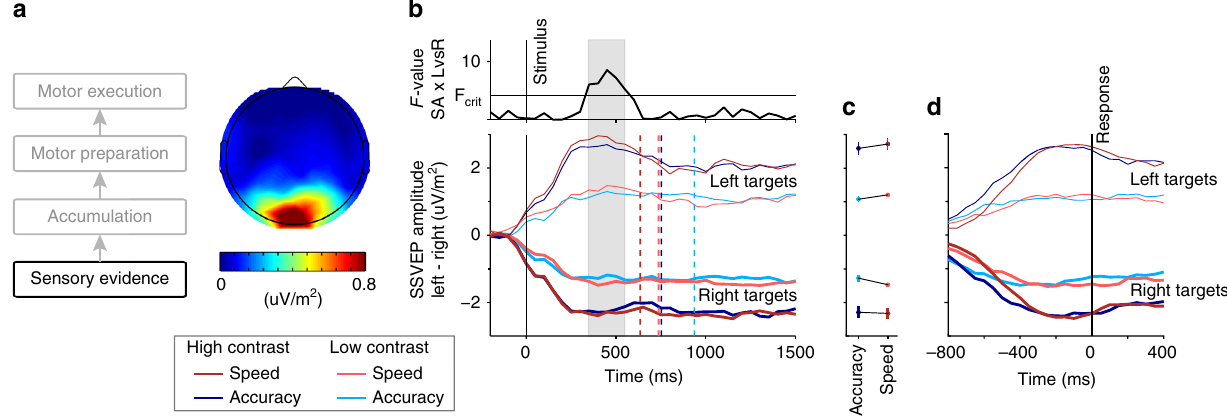
Fig. 2 Sensory evidence modulations due to speed pressure. a Average steady-state visual evoked potential (SSVEP) measured in the 800 ms before stimulus onset was maximal at occipital electrodes around standard site Oz. b The difference in amplitude between the steady-state visual response to the left- and right-tilted gratings underwent clear changes in the direction of the Target Type (increased-contrast in the left/right-tilted grating, thin/thick lines), and this directional effect varied in strength as a function of high/low Contrast difference (dark/light shades), and Speed/Accuracy Regime (red/ blue). Speci fi cally, there was an increased separation between the stronger sensory representation of the increased-contrast and the weaker representation of the decreased-contrast grating under speed pressure. Upper panel shows the strength ( F -value) of the Regime × Target Type interaction in a time- resolved fashion, illustrating the time frame during which the differential between left- and right-targets was signi fi cantly widened under speed pressure (shaded gray). Dashed vertical lines indicate mean RT of each condition. Note that the gradual initial increase/decrease in the differential SSVEP ( − 100 to about + 200 ms), despite the contrast change stepping instantaneously, is attributable to the fact that SSVEP amplitude at a given time is measured in a 400-ms window centered on that time, and this leads to the apparent deviation even before evidence onset. c Mean SSVEP amplitude in the a priori chosen time window between 250 and 450 ms after stimulus onset with error bars depicting the standard error of the mean across the 16 subjects. d Differential SSVEP amplitude plotted aligned to the response